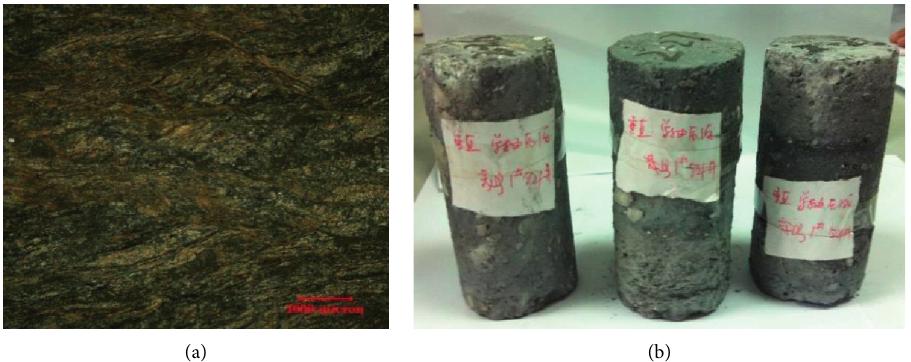
Figure 7: Rock specimens at XJ1K0+270. (a) Surrounding rock. (b) Rock specimens.